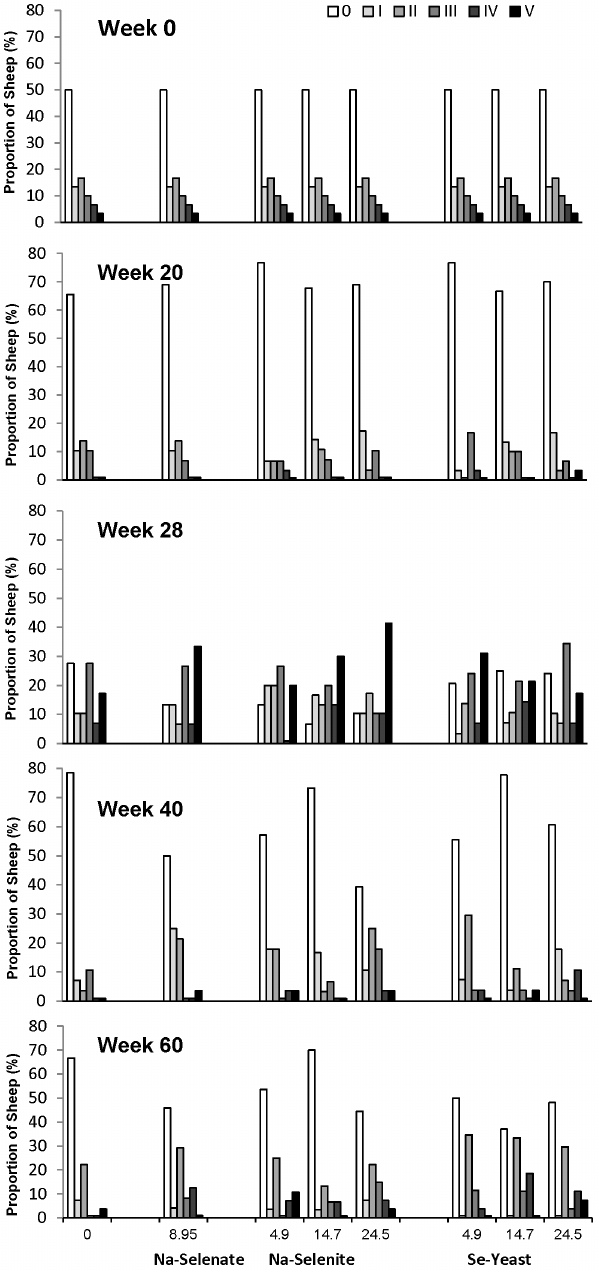
Figure 4. The effect of Se-source and dosage on foot rot (FR) severity in sheep. Foot rot severity was assessed after 0, 20, 28, 40, and 60 wk of Se supplementation in ewes receiving no Se treatment, Na-selenate at a dosage rate of 8.95 mg Se/wk per ewe, or Na-selenite and Se-Yeast at 4.9, 14.7, or 24.5 mg Se/wk per ewe for 62 wk. The proportion of sheep (%) in each FR-severity category within each treatment group is shown (scale 0 to V; with no FR = 0 being the lowest category). The scoring and categorization for FR is described in detail in the Materials and Methods. There were no consistent effects of Se source and dosage on FR prevalence and severity across time.